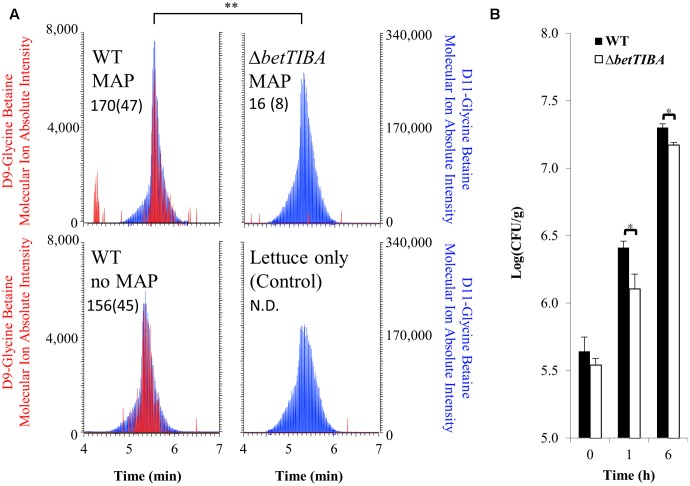
HPLC-MS quantification of D9-choline conversion to D9-GB in EcO157 WT and betTIBA mutant, and their growth in MAP cut lettuce. (A) Representative MS ion traces of D9-GB (left axis, red trace) from quantitative analysis in WT and betTIBA mutants cells recovered 6 h after single inoculation of their suspension amended with D9-choline onto cut lettuce incubated in bags under MAP (upper traces), or at room atmosphere (no MAP) (lower left trace). The lower right trace illustrates the lack of detection of D9-GB in uninoculated lettuce spiked with D9-choline and incubated for 6 h in MAP (control). The trace for D11-GB, which served as an internal standard is also shown (right axis, blue trace). Left and right axes indicate relative molecular ion intensity for representative peaks obtained for each treatment. Each trace is also shown with the amount of D9-GB produced by the strains; values are expressed as μmoles detected per L cell volume assessed in each bag (inferred from CFU determinations and assumption of 1 cubic μm volume per cell). Each value represents the mean from three replicate injections of samples from three replicate bags, with standard error of the mean provided in parenthesis. (B) Population dynamics of the WT and betTIBA mutant after their individual inoculation onto MAP cut lettuce. Each bar represents the mean population size per g cut lettuce from three replicate bags; error bars are standard error of the mean. ND, not detected. ∗ and ∗∗ indicate significant differences by Student’s t-test with P < 0.05 and P < 0.01, respectively.